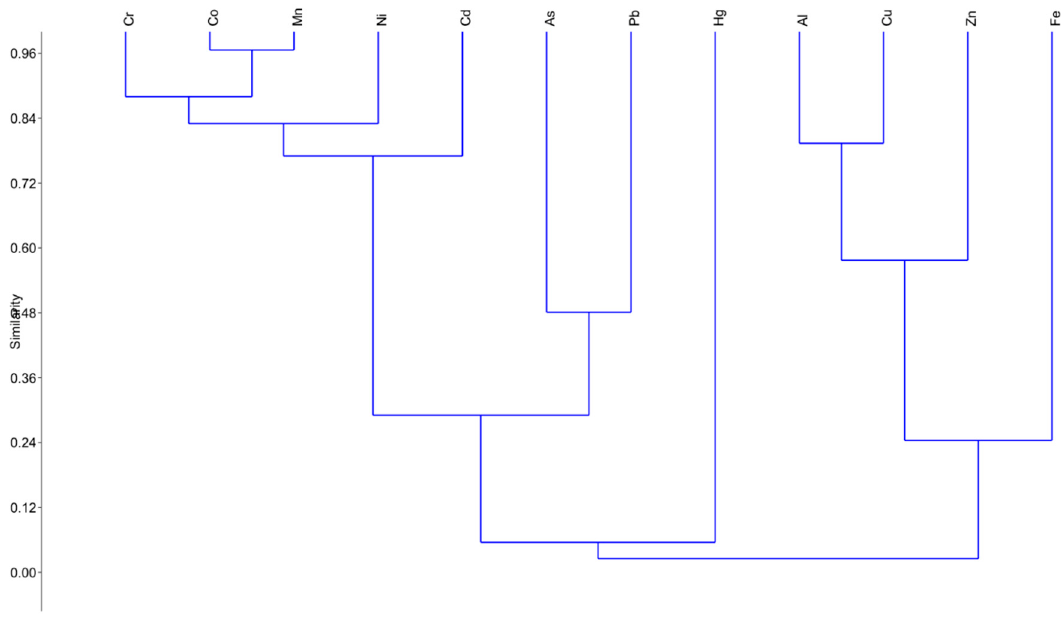
Figure 3. Cluster analysis: dendrogram of trace elements in Sinanodonta woodiana (unweighted pair-group average linkage, Bray–Curtis similarity index).